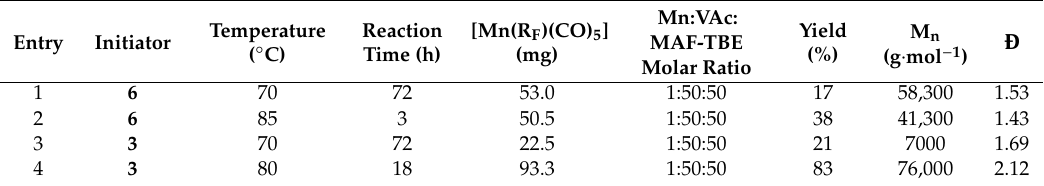
Scheme 2. Alternating copolymerization of VAc and MAF-TBE initiated by the [Mn(CH 2 CF 3 )(CO) 5 ] ( 3 ) and [Mn(COCHF 2 )(CO) 5 ] ( 6 ) complexes. R F stands for fluoroalkyl group and X represents Mn(CO) 5 or H or R F . Table 5. Experimental conditions and results of the copolymerization of VAc and MAF-TBE thermally initiated with compounds 6 and 3 . Table 1. Results for the VDF polymerization initiated by the thermal or photochemical activations of 1